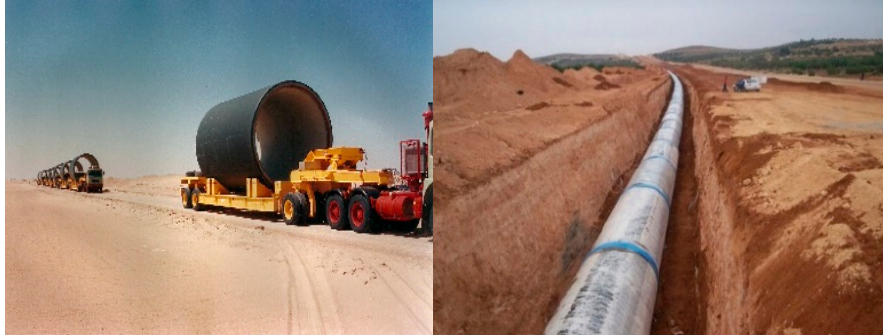
Figure 6. Transporting Pipes to become Part of the Great Man-made River in Libya. Credit: Wikipedia Commons.